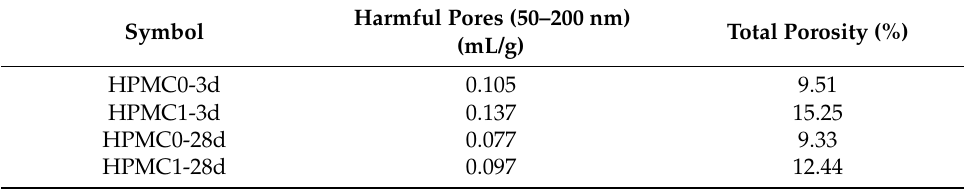
Figure 8. The pore structure of HPMC0 and HPMC1 at 28 days. Table 7. Harmful pores and total porosity of HPMC0 and